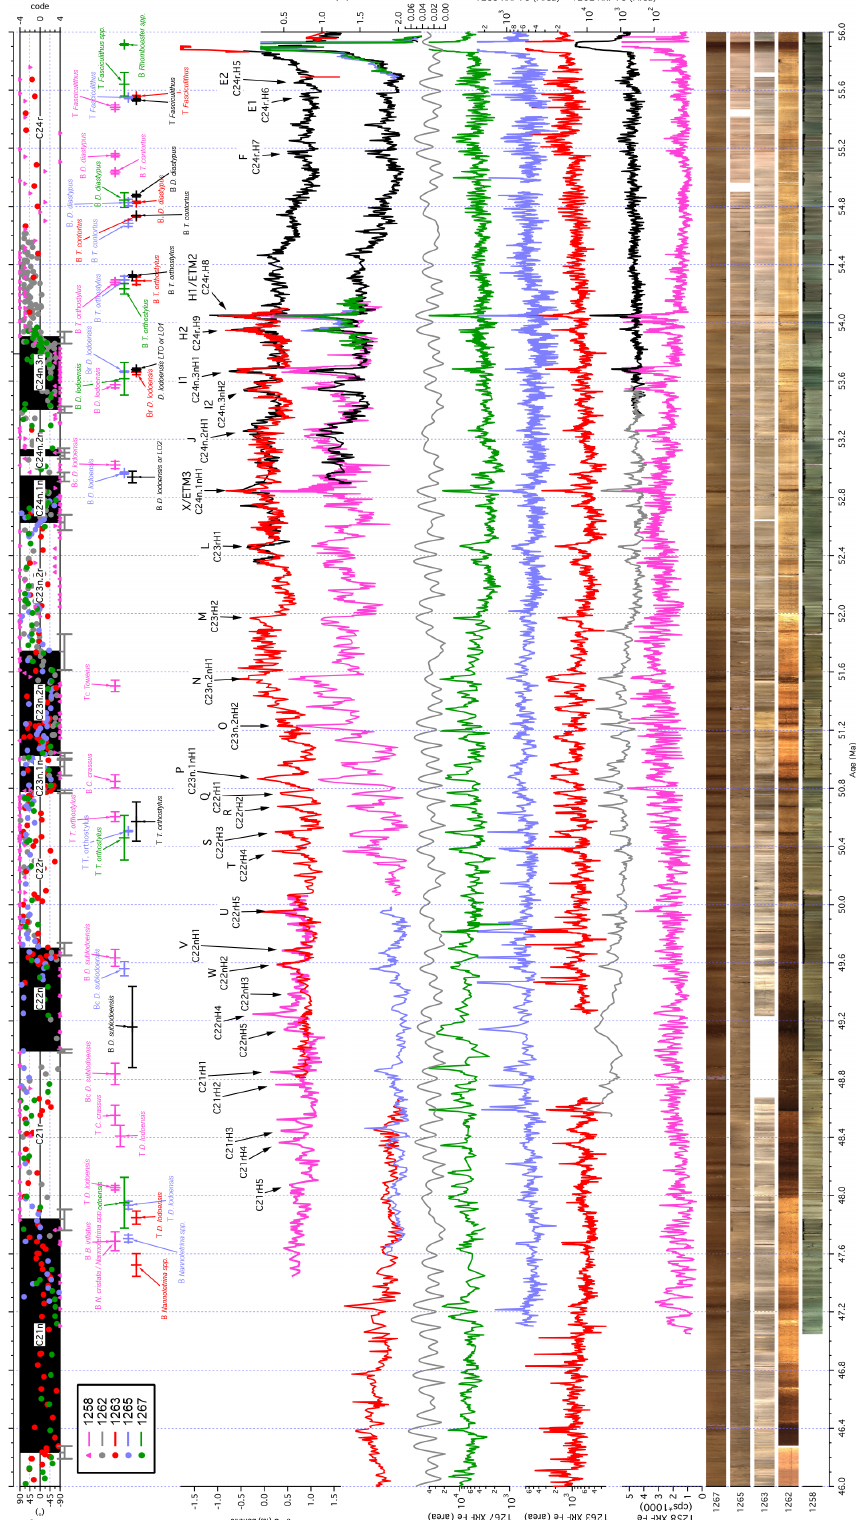
Figure 5. Bio- and magnetostratigraphic data, benthic and bulk stable isotopes, XRF core scanning Fe intensities, and core images for the new astrochronology for the Ypresian stage. Inclination data from ChRM analysis of each site from Leg 208 are shown. For Site 1258 the results of Suganuma and Ogg (2006) are given as a code between − 4 and 4, with negative values indicating reversed polarity. The final synthesized magnetostratigraphy (Table S45) includes the error for the reversals (bars). Also shown is the La2010b (Laskar et al., 2011a) orbital solution by the central grey line. Note the extremely good match between orbital solution and amplitude modulation in the various XRF and stable isotope records. Hyperthermal events have been labeled according to Table